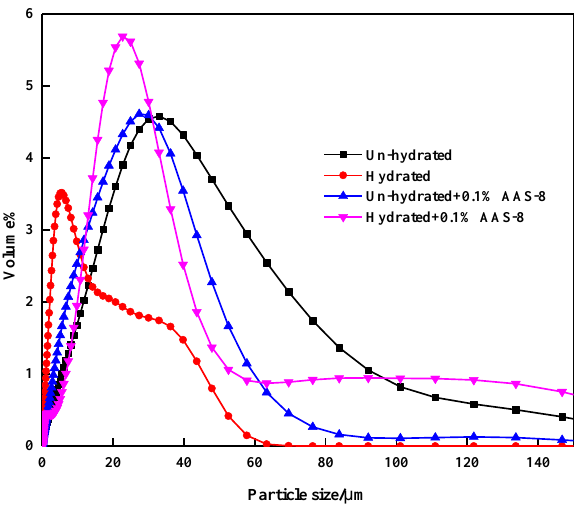
Figure 4. Distribution of clay particle size in different solutions. Table 3. Average clay particle